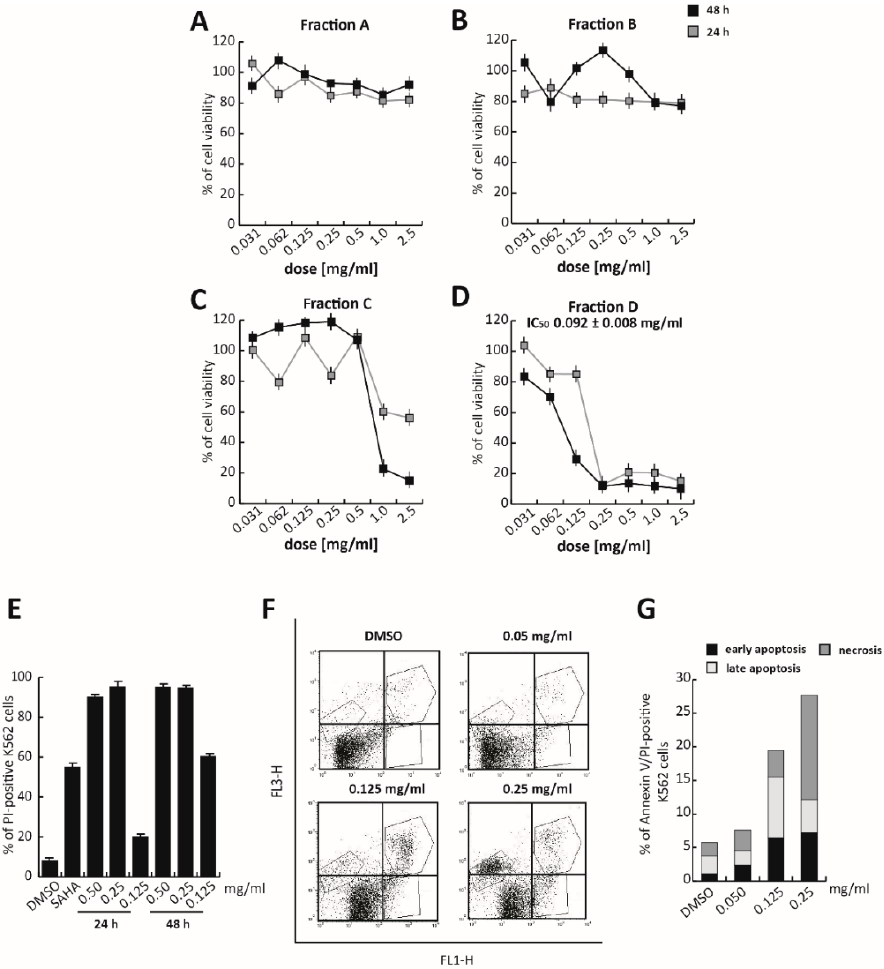
Figure 3. Antiproliferative effects of Fraction D in K562 cells. K562 cells were treated for 24 and 48 h with ( A ) Fraction A, ( B ) Fraction B, ( C ) Fraction C, and ( D ) Fraction D, at seven different concentrations from 2.0 mg/mL to 0.031 mg/mL. ( E ) K562 cell death analysis by propidium iodide (PI), after treatment with Fraction D at the indicated times and concentrations. SAHA (N’-hydroxy-N-phenyloctanediamide; Vorinostat) was used at 5 μ M, for 24 h, as a positive control. ( F , G ) K562 apoptotic cell death analysis by Annexin V / PI experiments after treatment with Fraction D at the indicated concentrations for 24 h. Values are mean ± SD of biological